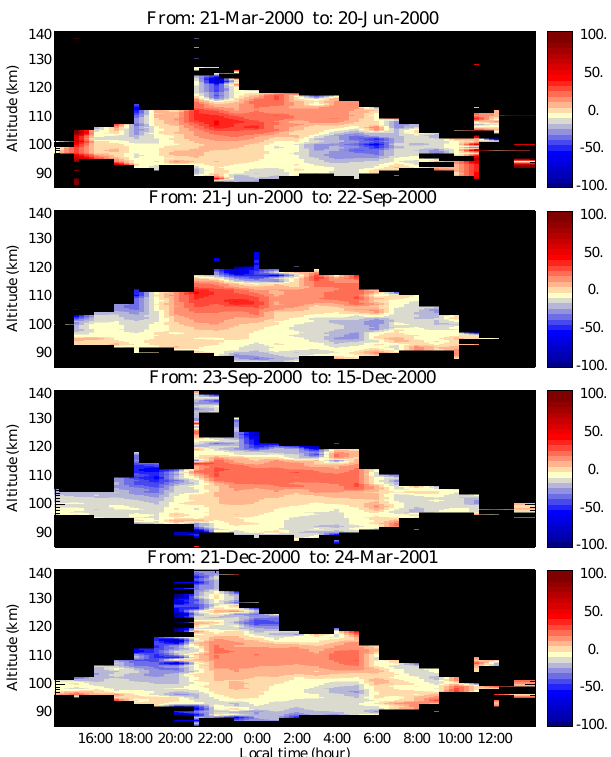
Fig.9. Diurnal Doppler velocity from E-region echoes as a function of altitude for different periods of the year: fall, winter, spring, and summer in the first, second, third and fourth rows, respectively. No valid data are represented in black